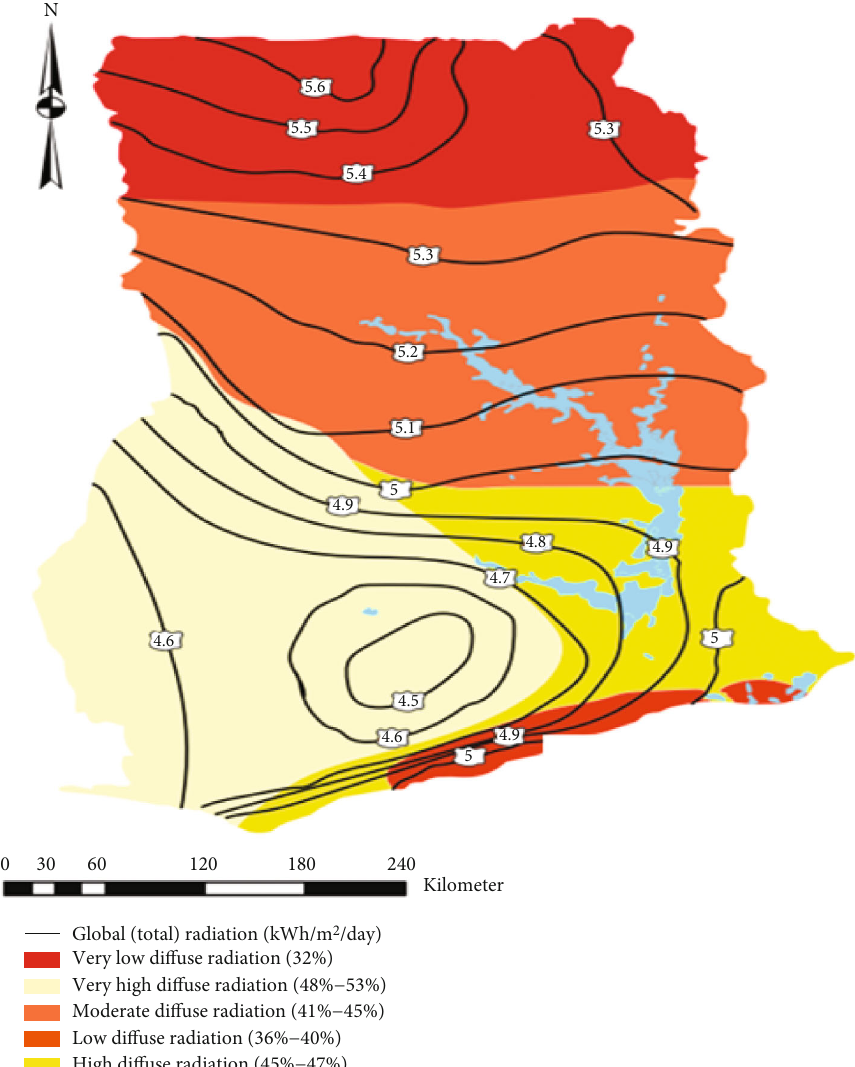
Figure 6: Global solar radiation in Ghana